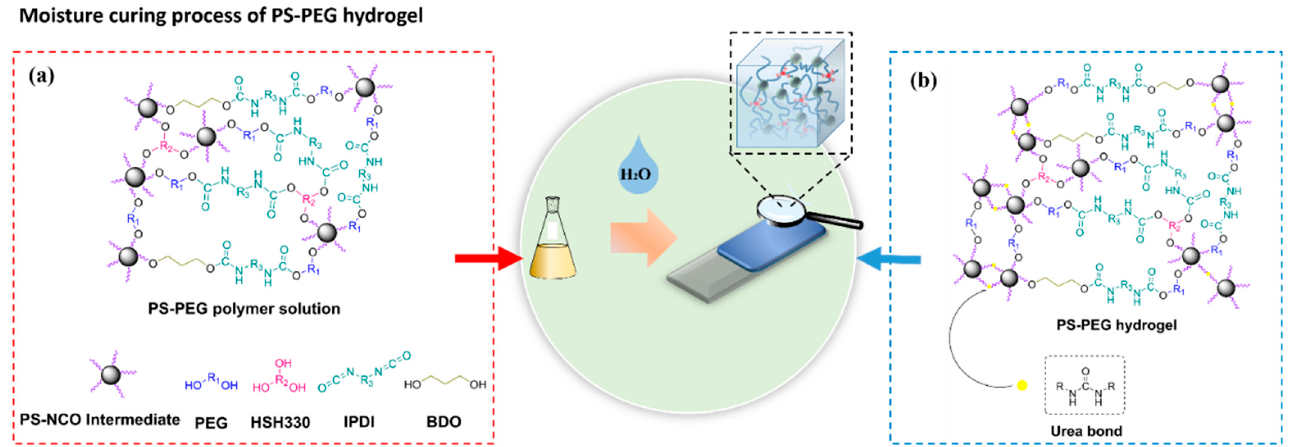
Figure 1. Moisture-curing mechanism of hydrogels: ( a ) isocyanate-terminated PS-PEG polymer solution; ( b ) isocyanate groups react with water to form urea bonds.